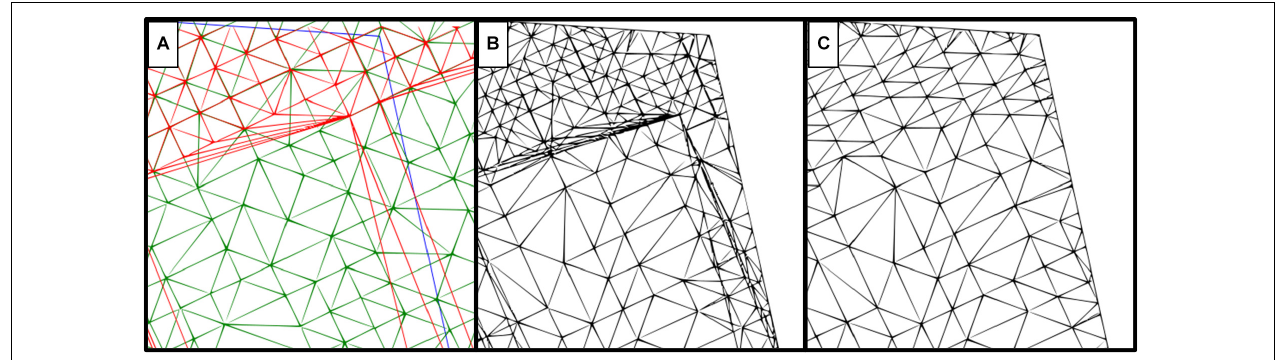
FIGURE 3 | Comparison of two difference model computation methods using the same reference surfaces. (A) Surfaces used for computation, where red represents the soil reference, green is the canopy surface generated from the point cloud, and a blue line demarcates the plot border. (B) Difference model using the “trace all triangles” method. (C) Difference model using the “do not track breaklines”